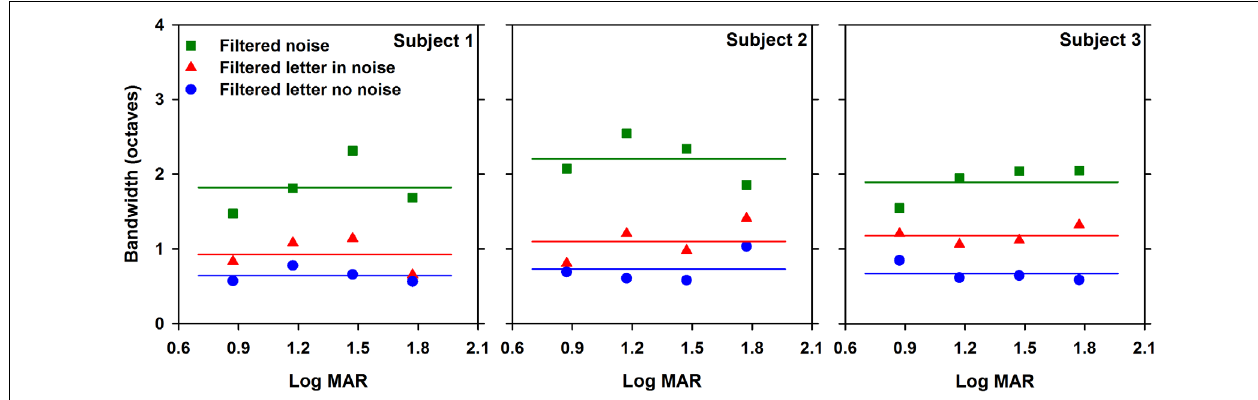
FIGURE 4 | Bandwidth (octaves) as a function of log MAR letter size. Data are shown for each subject individually. Linear regression lines with slopes of zero are fit to the data, as described in the text.